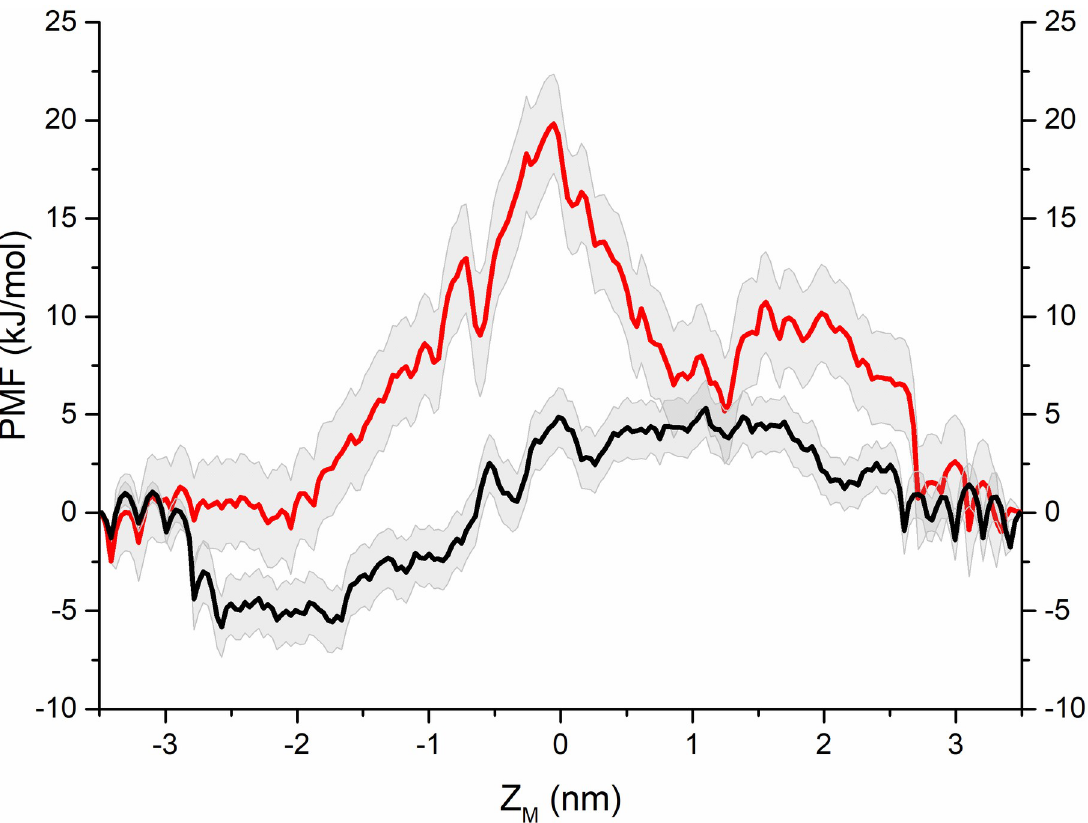
Fig 3. PMF associated with water permeation through the channel pore of ORF1 (black curve) and ORF8 (red curve) pentamer.